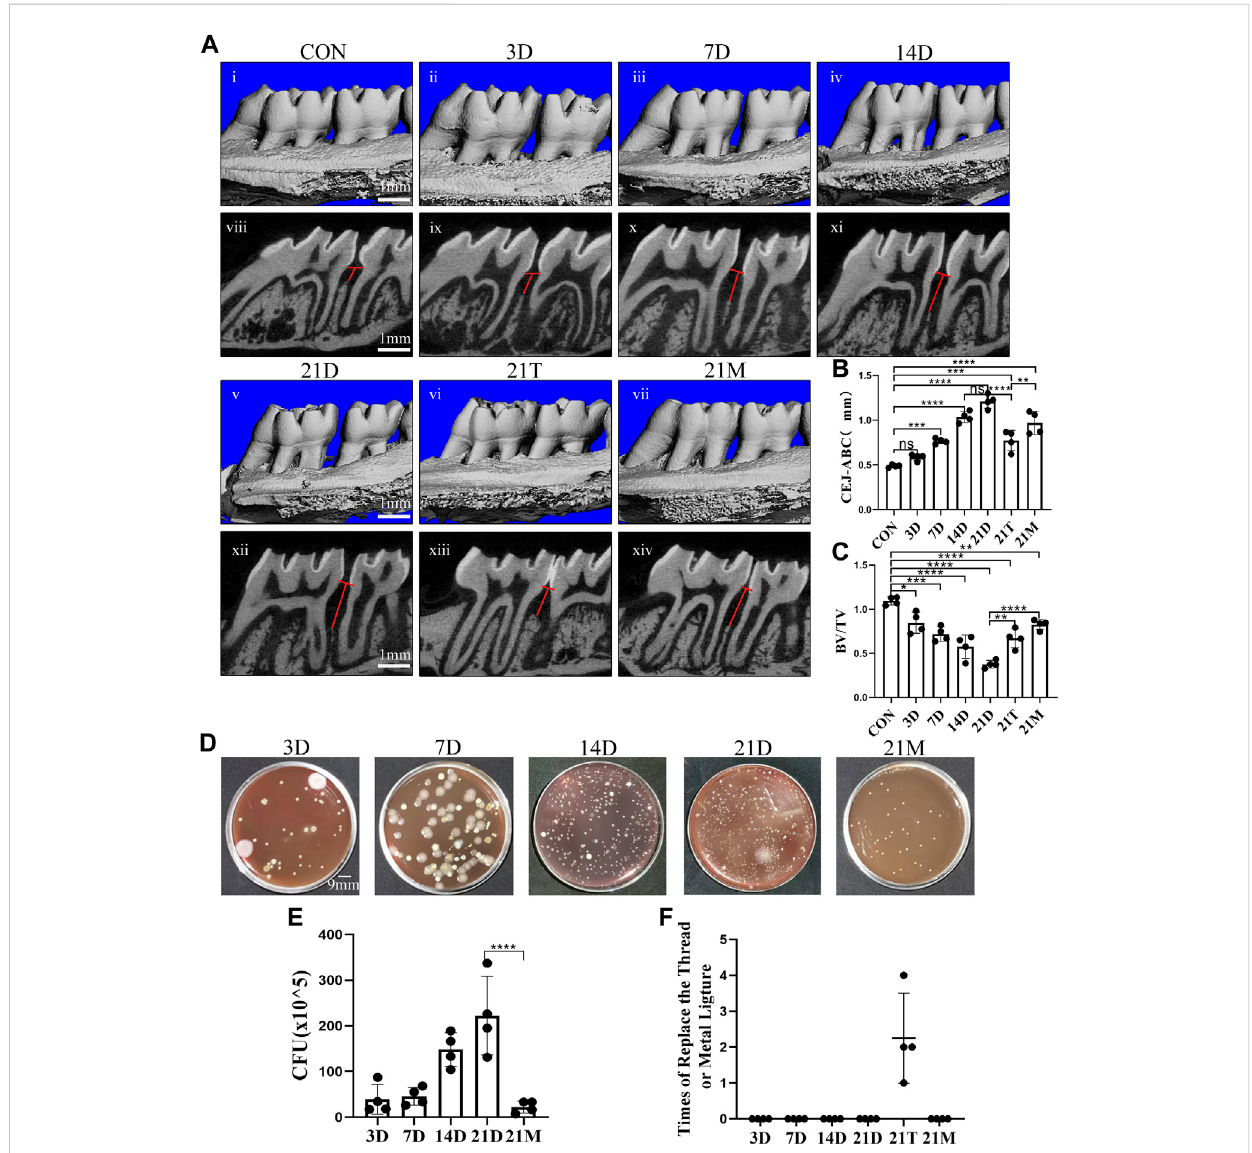
FIGURE 2 Degreeofalveolarbonelossandbacteriaaccumulationaftermodeling. (A) Representativesagittal 3D(i-vii)andbi-dimensionalviews(viii-xiv)ofthe maxillarymolarsfromCTscanningofthecorrespondgroups.Theredlinecorrespondstothedistancesfromthecementoenameljunctiontothealveolar bonecrest(CEJ – ABC). (B,C) MeasurementofthedistancefromtheCEJ totheABCandtheratioofbonevolumetotissuevolume(BV/TV)ateachgroup after modeling. (D) Photograph ofcolony forming unit(CFU) fromthe3Dgroup, the7Dgroup, the14Dgroup, the21Dgroupandthe21Mgroup.